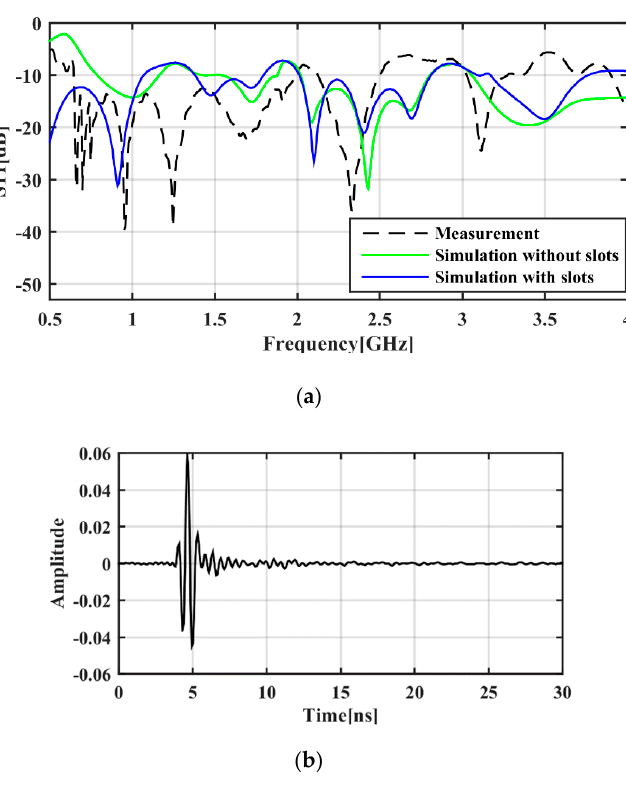
Figure 9. ( a ) The measured S11 of designed Vivaldi antenna with shorting slots and the simulated S11 of the proposed Vivaldi antenna with and without shorting slots; ( b ) The measured result of S12 in time domain of the designed Vivaldi antenna with slots.